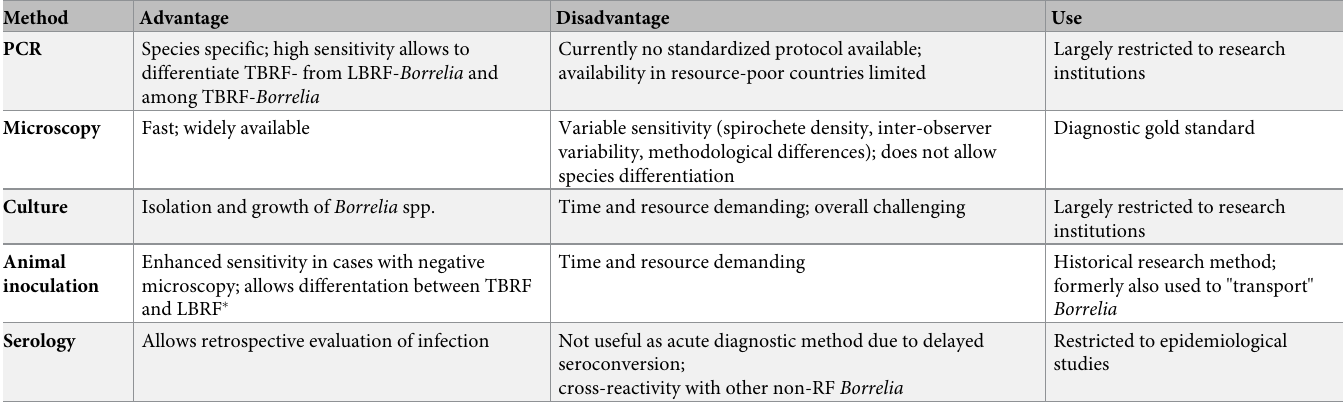
Table 1. Overview of laboratory methods applied in TBRF and their advantages, disadvantages and use.